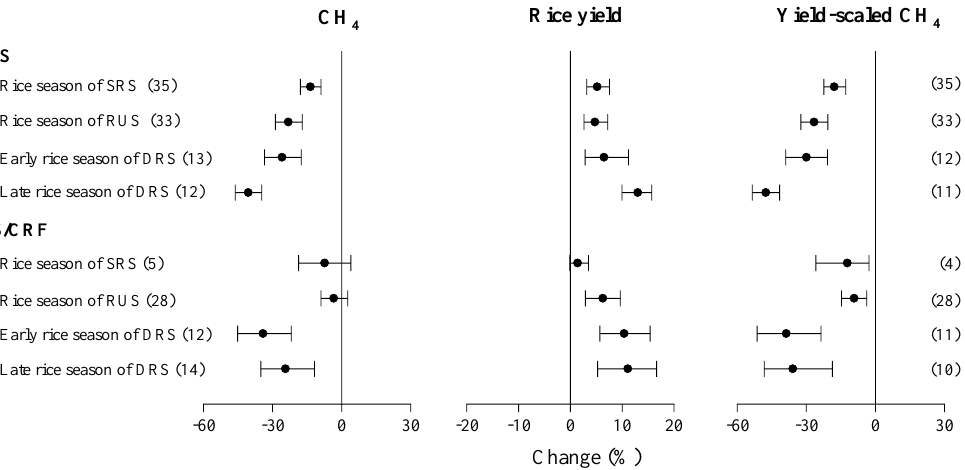
Figure 4. Impacts of cropping system on the efficacy of IS and S/CRF on CH 4 , rice yield, and yield-scaled CH 4 emission from rice fields.